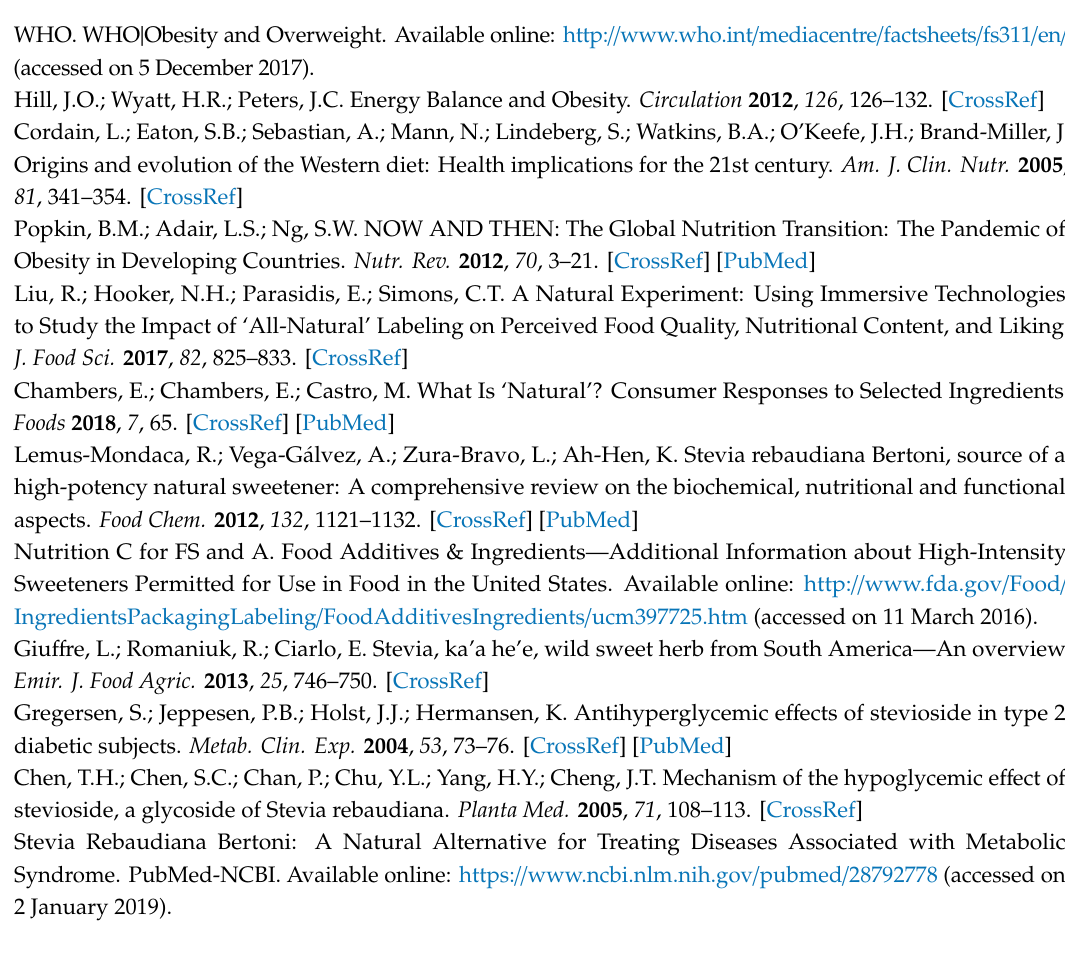
Figure S1: Relative abundance of (A) Bifidobacterium pseudolongum and (B) Akkermansia muciniphila in control, prebiotic, stevia, and stevia + prebiotic consuming rats, Table S1: Composition of experimental diets from age 3- to 8-weeks, Table S2: Composition of experimental diets from age 8- to 12-weeks 1